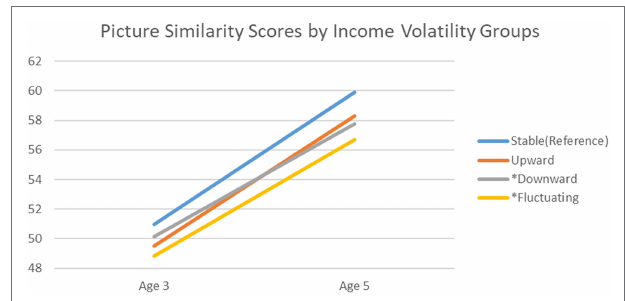
FIGURE 3 | Trajectory of picture similarity scores from age 3 to 5 across income volatility groups. Note: *Statistically significant change between volatility group and stable income group in the regression